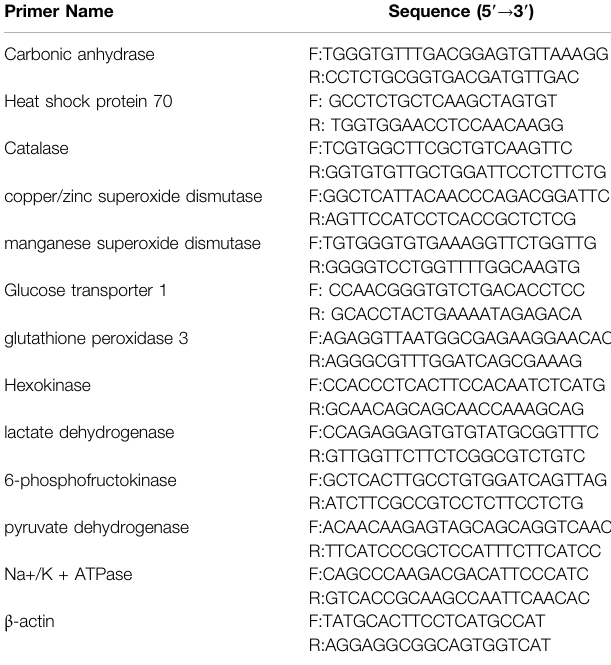
TABLE 1 | The speci fi c primers used to in this